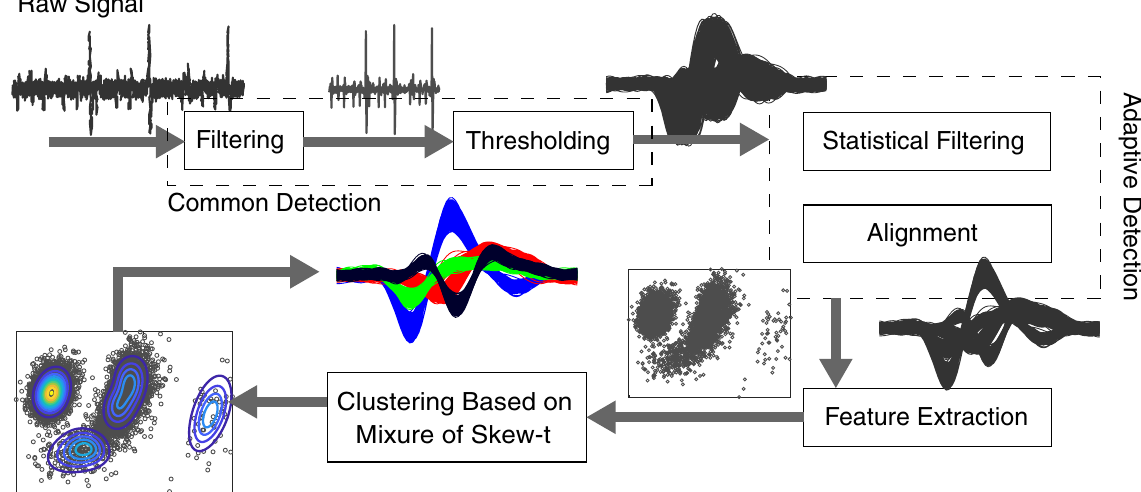
Figure 2. Illustration of the procedure of the proposed automatic spike sorting algorithm. First, the raw signal is fed into a common detection procedure. As an example, first, the signal is filtered, then, an initial detection is performed by applying a simple thresholding procedure. Thereafter, the proposed adaptive detection procedure takes the initially detected spikes and performs a set of procedures to improve the detection results and make them ready for feature extraction. In adaptive detection, first, the noise which is detected as waveforms are removed using the proposed statistical filtering. Then the proposed multi-point alignment seeks to align the waveforms based on the histogram of the extremums. Then, an adaptive number of principal components are considered as features. Finally, the samples are fed to the clustering method based on the mixture of skew-t